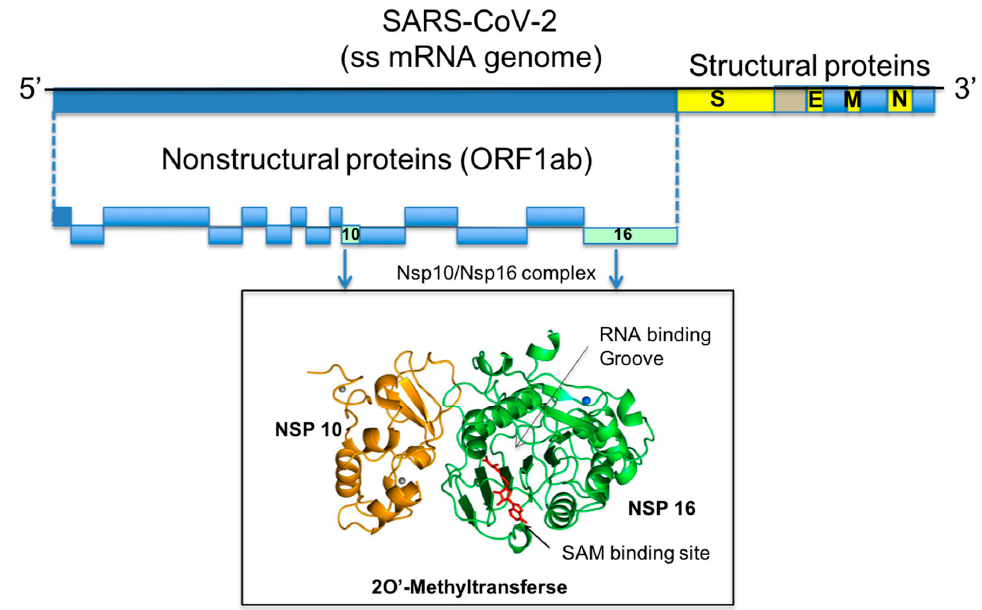
Figure 1. Genome organisation of SARS-CoV-2. The regions encoding for the NSP10 and NSP16 proteins are highlighted and their 3D structures show in cartoon representation.